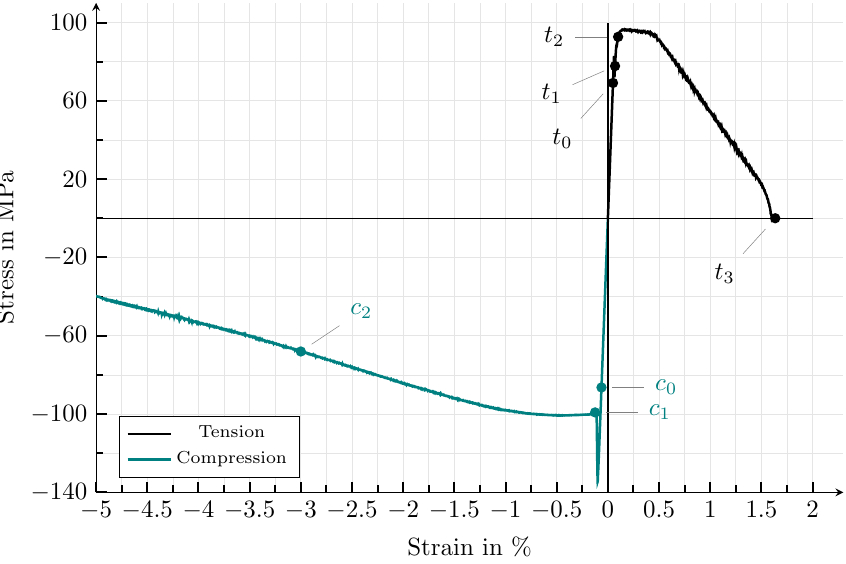
Figure 12. Homogenised macroscopic stress–strain response of a simulation domain, inspired by an idealised cast iron microstructure with lamellar graphite. The diagrams show the stress and strain in the case of uniaxial tension and compression. The dots in the stress–strain diagram correspond to the strain states of the contour plots of Figures 10 and 11. Even though the simulation domain is not a representative volume element, a clear tension–compression dependency of the stress–strain plot can be observed when looking at the peak stresses and the elongations at